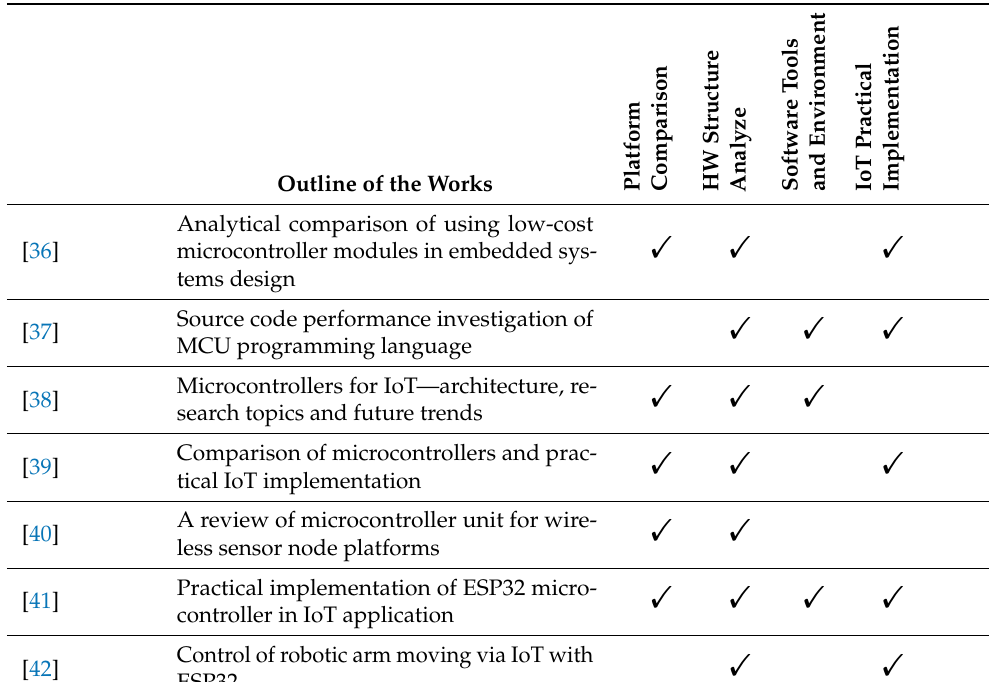
Outline of the Works Analytical comparison of using low-cost microcontroller modules in embedded sys-